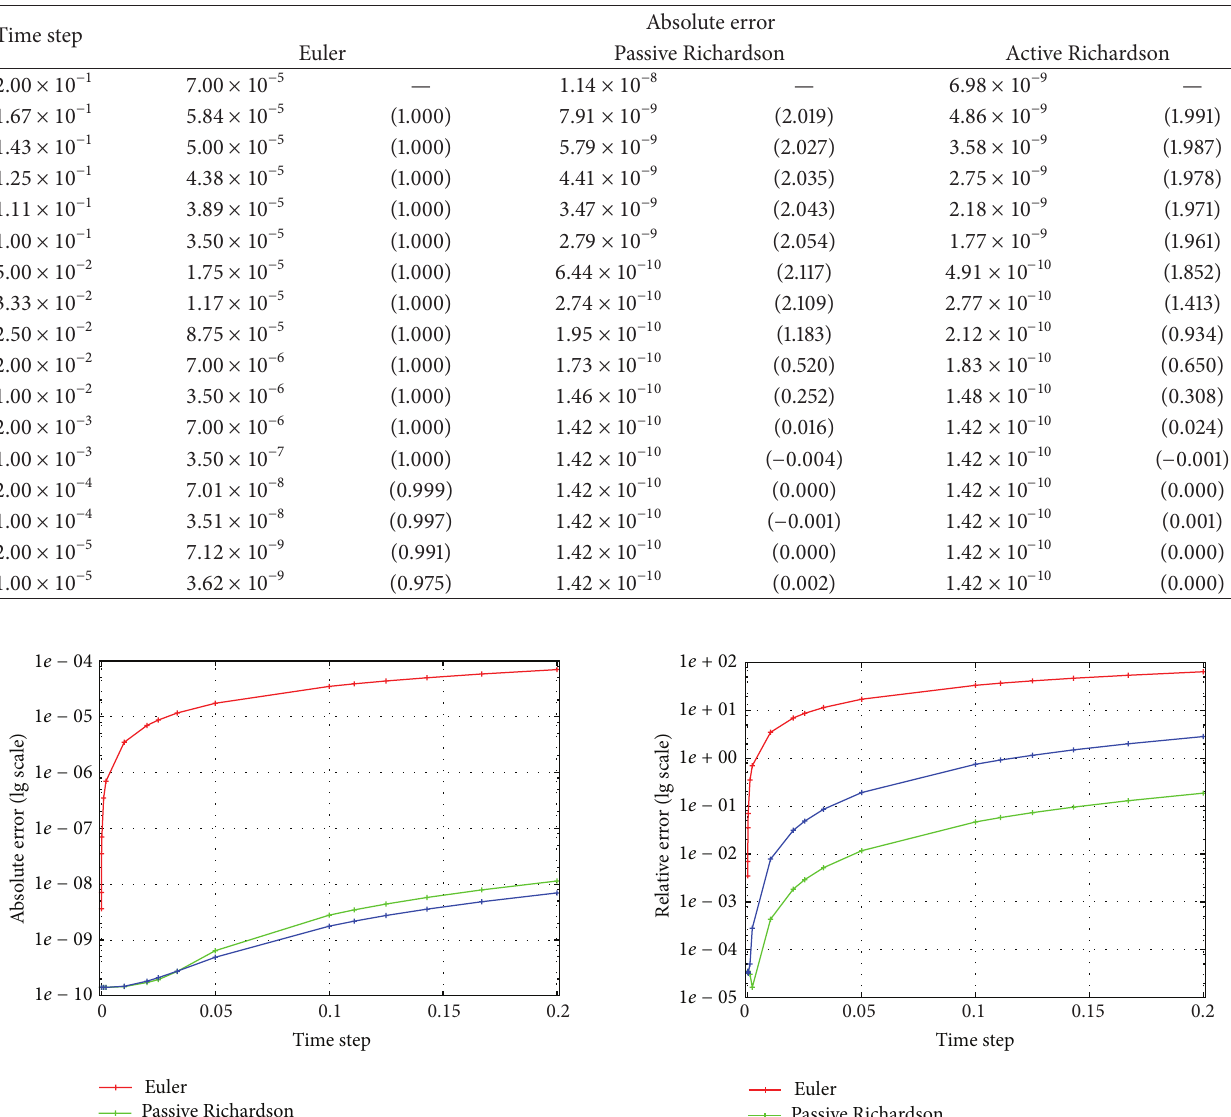
Table 1: Absolute error of the diffusion problem without and with passive/active Richardson extrapolation (with the estimated convergence order in parentheses).